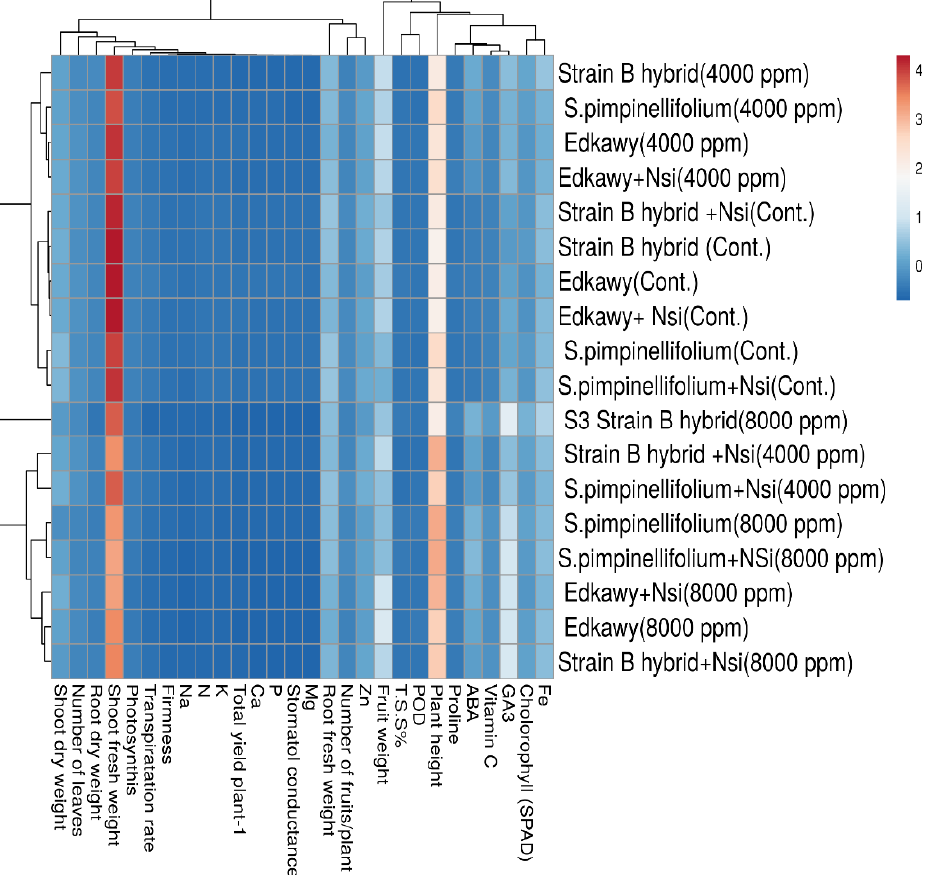
Figure 5. Heatmap of salinity stress, rootstocks, and measured parameters of tomato samples. The differences in the response variables between all studied treatments are visualized in the heatmap diagram. Columns represent the individual response variables, while rows represent the treatments. Lower numerical values are colored blue, whereas higher numerical values are colored red (see the scale at the bottom right corner of the